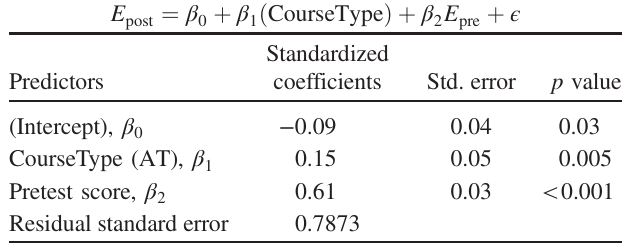
TABLE VIII. Coefficients for ANCOVA for post-test scores while controlling for pretest scores for women. The table lists the standardized coefficients and the p values of the ANCOVA results for the CourseType category.